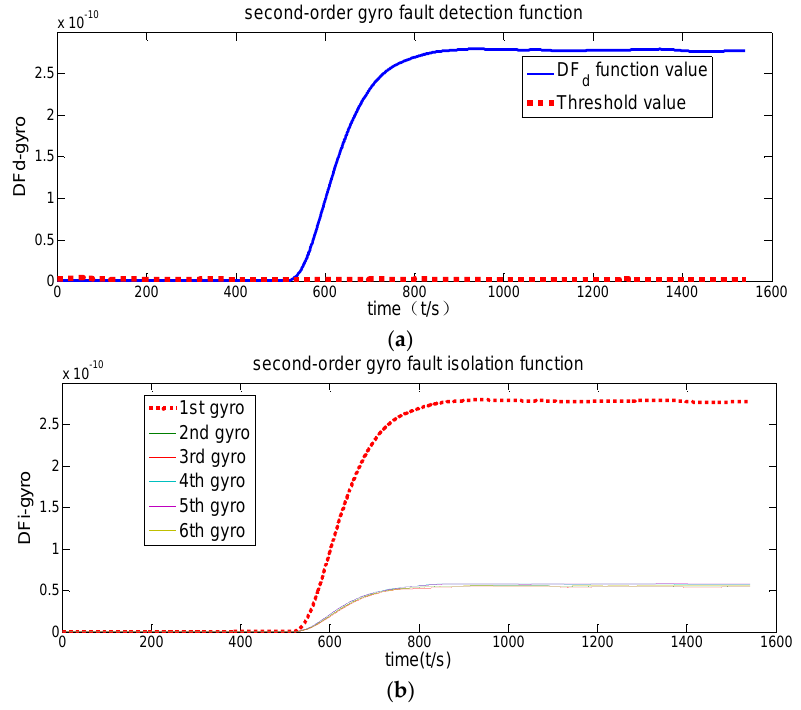
Figure 7. Second-order channel filter (the fault amplitude is 5 ◦ /h). ( a ) Fault detection; ( b ) Fault isolation.